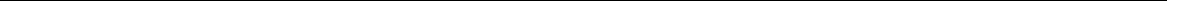
Fig. 6 Function of projection neurons in phototaxis. a Larvae of all genotypes steer away from light. + / shi TS : n = 10, p = 2.2 × 10 − 4 ; PVL09 > shi TS : n = 10, p